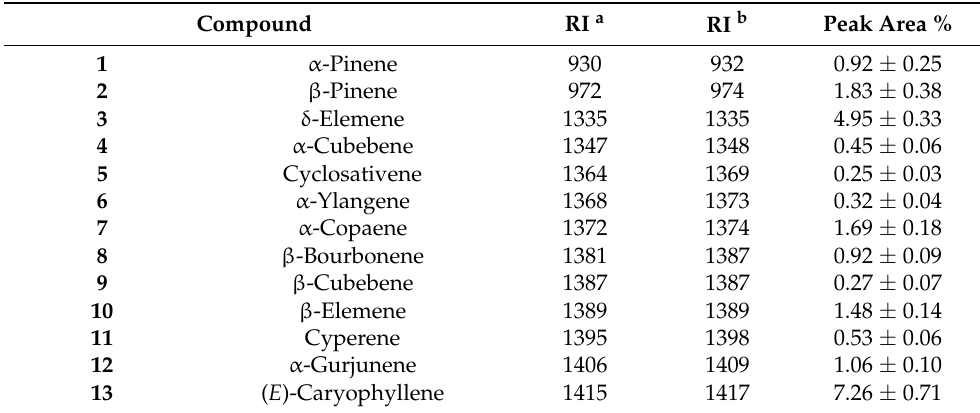
Table 1. Chemical composition of G. olivacea leaf EO.